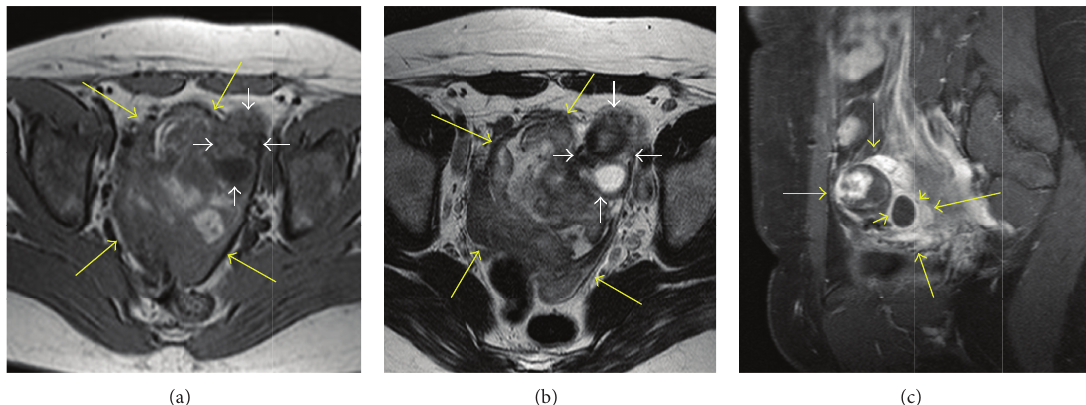
Figure 3: Image (a) is a noncontrast T1 axial image through the pelvis which demonstrates a large pelvic hematoma (large arrows) showing heterogeneous hyperintense signal related to the blood products. An additional smaller tubo-ovarian mass is noted in the left pelvis (small white arrows) which contains a posterior cystic component. Image (b) is a T2 axial image through the same area showing central hematoma (large arrows) and left tubo-ovarian mass (small arrows) with cystic component. Image (c) is a postgadolinium sagittal image through the left adnexa which shows heterogeneous enhancement of the tubo-ovarian complex mass (large arrows). The posterior aspect of this mass shows a thick-walled cystic structure with enhancement of the wall (small arrows). This corresponds to the cystic structure seen on US with “ring of fire” appearance in Figure